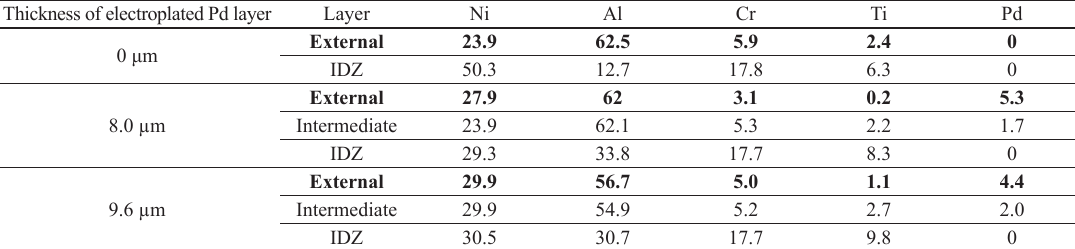
Table 4. Average chemical composition (at. %) of layers for the unmodified and Pd-modified aluminized coatings after processing at 1030 °C. Thickness of electroplated Pd